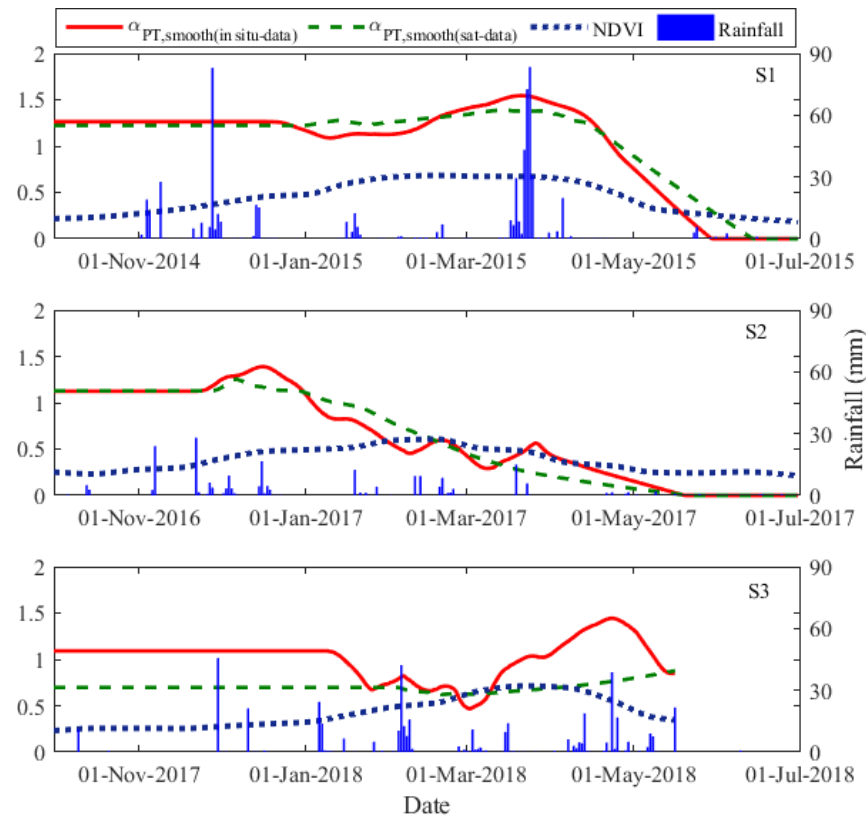
Figure 7. Time series of calibrated daily α PT (red – using in situ data, green – using satellite data) superimposed with NDVI and the rainfall events during S1, S2 and S3,